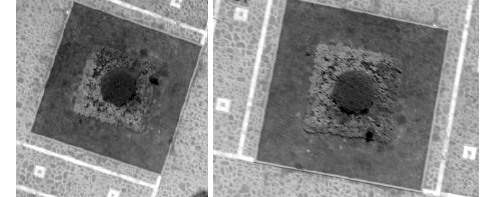
Figure 2(a) stereo-image thumbnails from air-ship with big difference in pitch angle and small difference in roll angle and rotation angle. The image size of left image 300pixel  400pixel which is the same for right image.